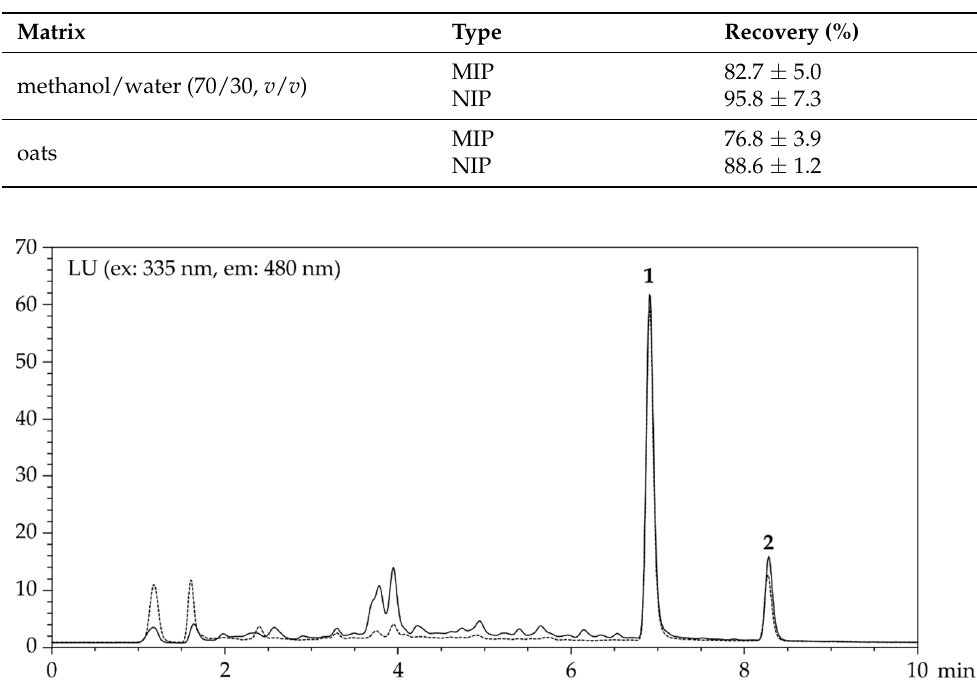
Table 6. Recovery and precision of OTA (30 ng/mL) quantification by MISPE using core-shell MIP and NIP imprinted by RHO (mean ± RSD, n = 6).